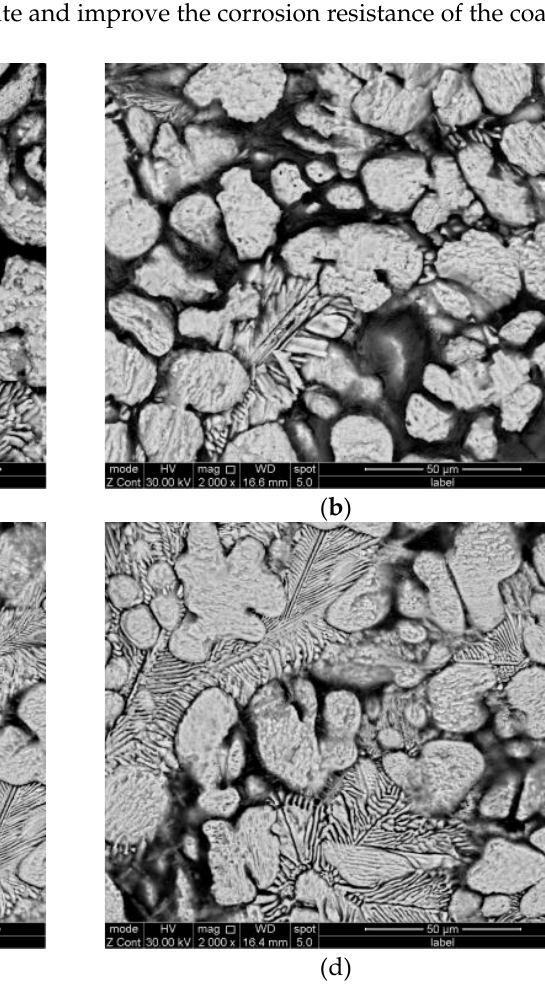
Figure 10. The SEM results of the experiment coatings, removing corrosion products after 15 weeks of a cyclic salt spray test’ ( a ) Zn-1.0Al-1.0Mg, ( b ) Zn-1.3Al-1.3Mg, ( c ) Zn-1.6Al-1.6Mg, ( d ) Zn-2.1Al- 2.1Mg .